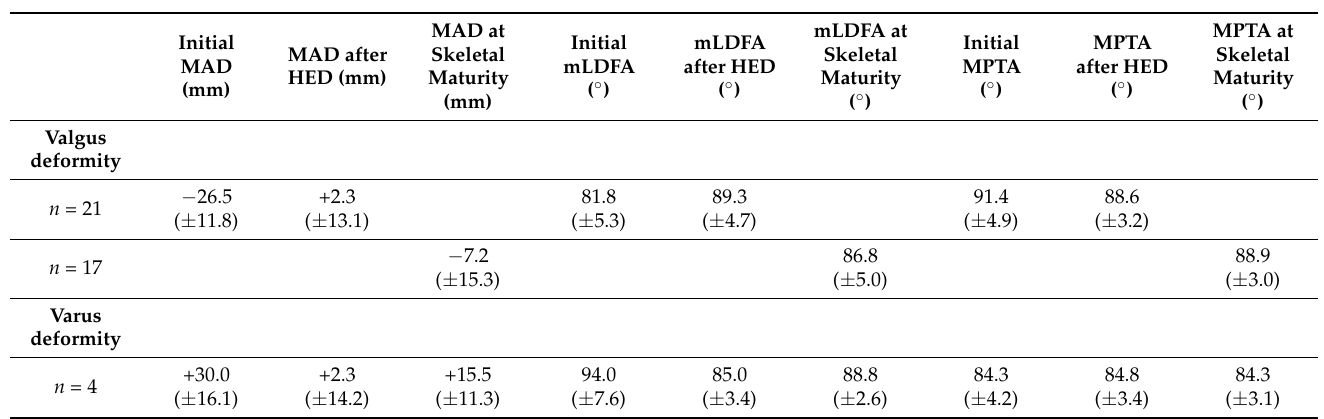
Table 2. Radiological parameters of guided